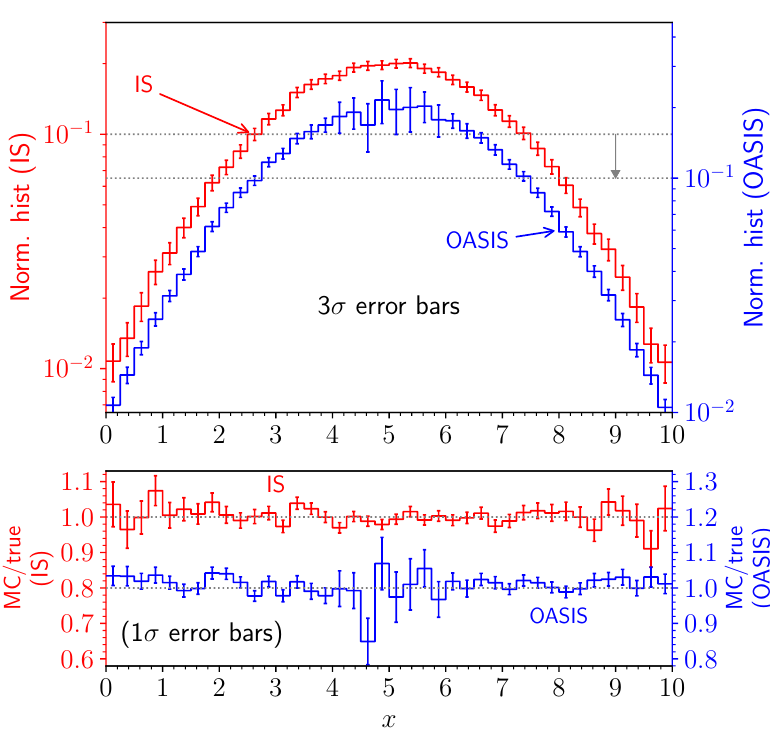
Figure 3: Normalized histogram counts with 3 σ error bars with 100,000 events sampled (and weighted appropriately) under the OASIS-trained distribution (blue lines) and the true distribution (red lines labelled IS). To allow for visual compari- son, the histograms are plotted on a log-scale and their corresponding y -axes have been shifted vertically as indicated by the vertical arrow. The bottom panel shows the ratio of the simulated counts to the true expected count (calculated by integrating the true distribution within each bin), along with 1 σ error